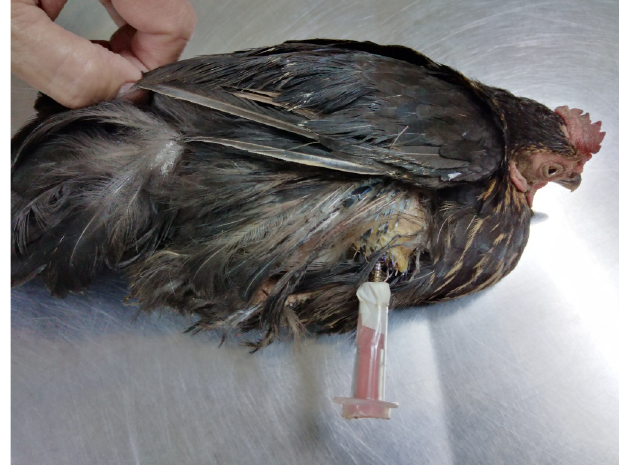
Fig. 4. Acrylic and some part of endotracheal tube as an exoprosthesis leg part was remodeled with screw’s stump